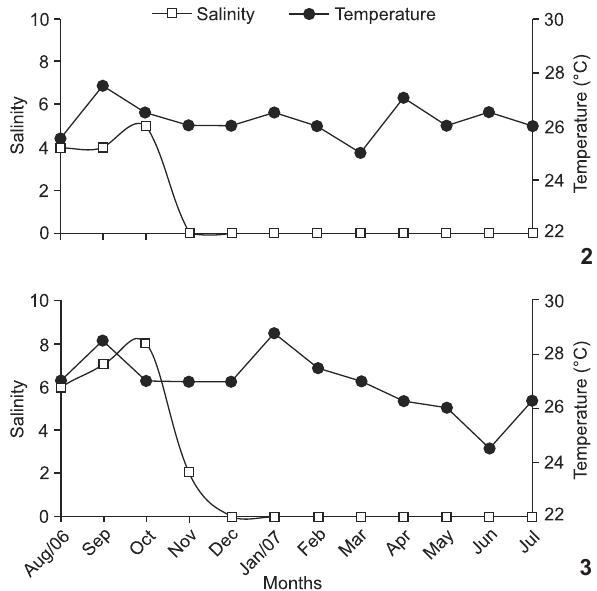
Figures 2-3. Temperature (°C) and salinity mean values from Au- gust 2006 to July 2007: (2) Arapiranga Island, and (3) Mosqueiro Island, Amazon estuary of